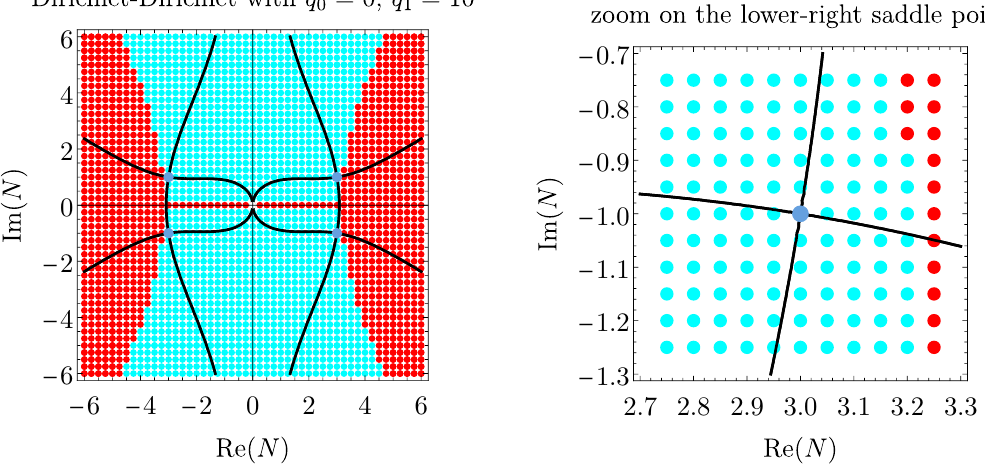
Figure 14 . In the left panel, a numerical plot in the complexified lapse plane of the allowed (cyan) and disallowed (red) metrics satisfying initial and final Dirichlet conditions, as appropriate for a field space definition of the no-boundary wave function. Here D = 4 , Λ = 3 , q ( t = 0) = 0 , and q ( t = 1) = 10 . This time the saddle points (in blue) do not reside at the boundary of the allowable domain, but are surrounded by allowable metrics, as can be seen more clearly in the zoomed in version in the right